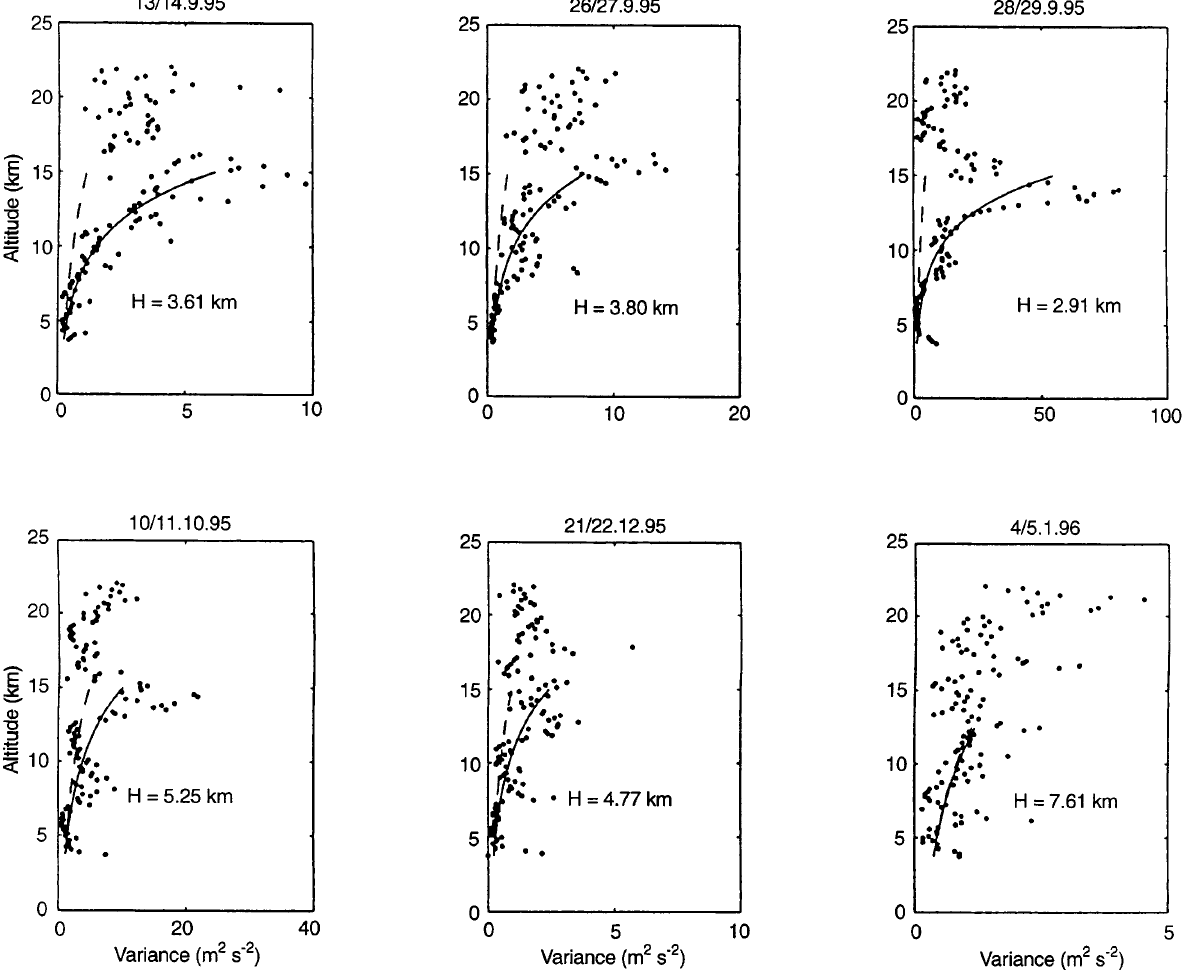
Fig. 5. Altitude variations of the mean square wind fluctuations ( points ). The solid lines represent exponential curves fitted by least squares method to the observations. The dashed curves are exponential curves with scale height equal to the neutral density scale height (8